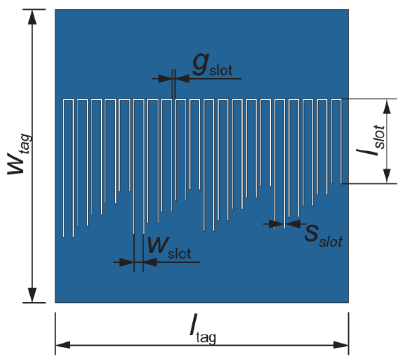
Figure 6. Sketch of 20-bit re-arranged U-slots in the metallic plate tag. Table 2. Dimensions of U-Slots in the metallic plate.